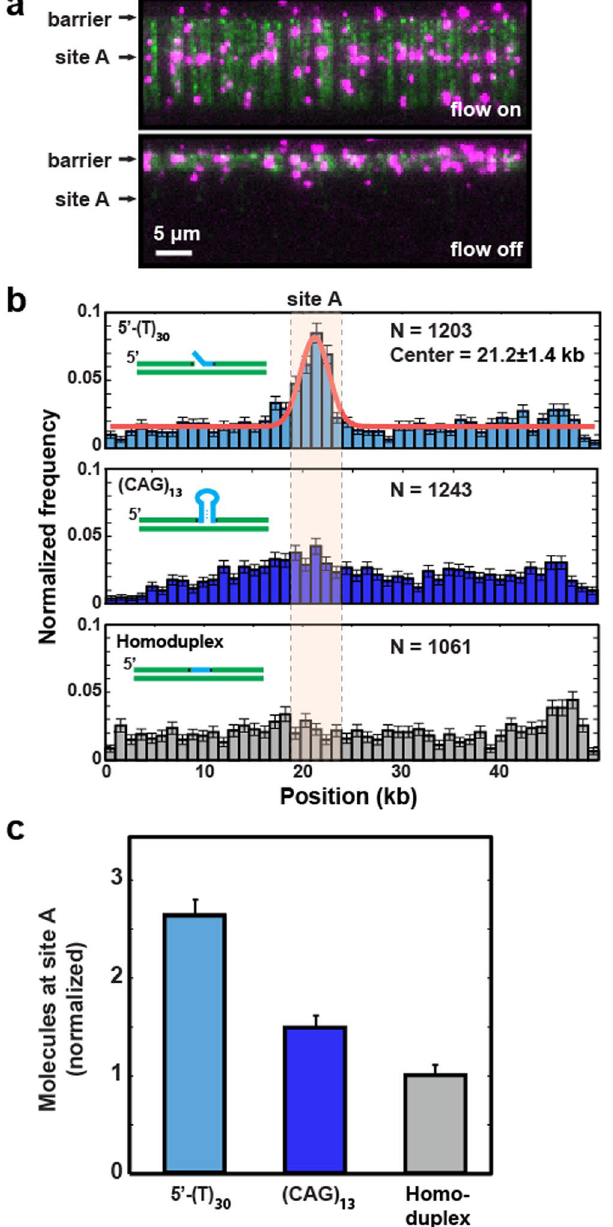
Figure 4. yRFC loads yPCNA on various extrahelical DNA structures. ( a ) Fluorescent images of yPCNA on DNA substrates with a 5 ′ -ssDNA flap inserted at site A. Top: with buffer flow, bottom: without flow. DNA is stained with YOYO-1 (green) and yPCNA is labeled with anti-FLAG antibody conjugated QDs (magenta). Stopping buffer flow retracts both yPCNA and DNA to the Cr barrier, confirming that yPCNA is bound to the DNA and is not on the surface (bottom panel). ( b ) Binding distribution histogram of yPCNA/yRFC on λ -DNA molecules containing a 5 ′ -ssDNA flap (top), (CAG) 13 repeat (middle), and homoduplex DNA (bottom). Red line: fit to a Gaussian distribution (center = 21.2 kb ± 1.4 kb; st. dev.). Pink box: a 5 kb window that captures 99% of all yPCNAs at site A (see text for details). ( c ) The mean number of yPCNA molecules loaded at site A (within the pink box), as determined by bootstrap analysis of the histograms in ( b ). Error bars represent the st. dev. of the mean from the bootstrap